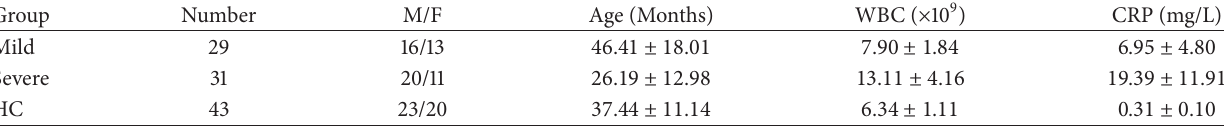
Table 1: Clinical characteristics of 60 recruited children with HFMD caused by EV71